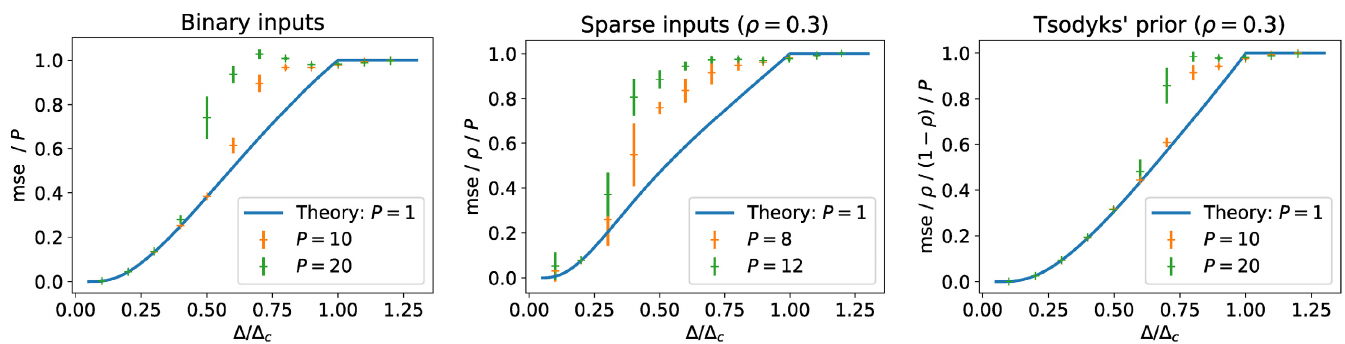
Fig 4. MSE from reconstructing with the mean-field prior approximation. We plot the final mse obtained by the AMP algorithm (no damping), using a mean-field approximation to compute the threshold function. The solid line is the mse predicted by iterating the state evolution for the scalar variable, Eq (14). We choose N = 5000 and set τ =